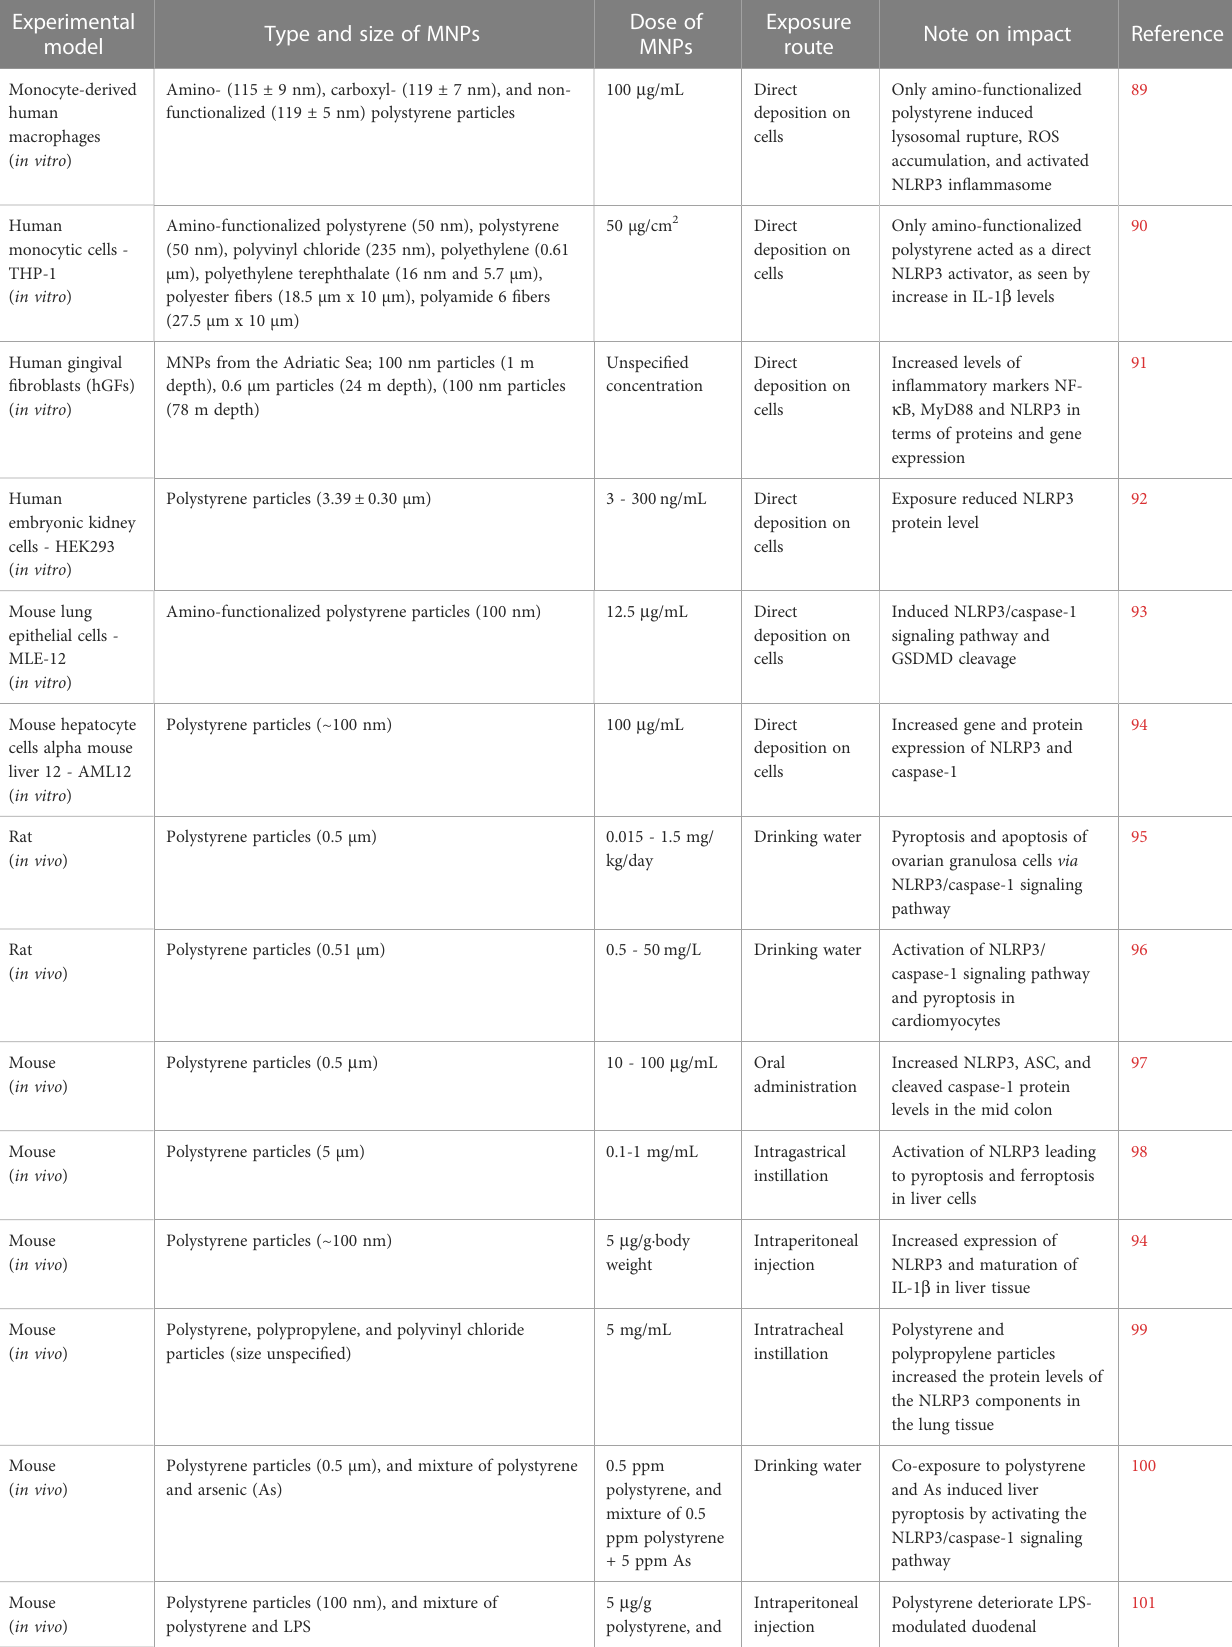
TABLE 1 Overview of the studies, identi fi ed and included in the present review, describing impact of micro- and nanoplastics (MNPs) on the NLRP3 in fl ammasome activation both in vitro and in vivo .